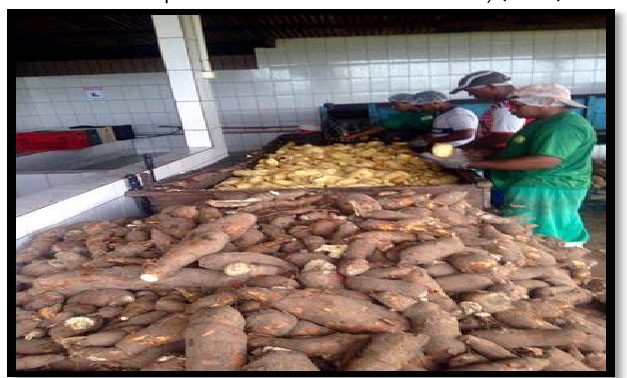
Figura 4: Área externa do tanque de lavagem (Basquetas com